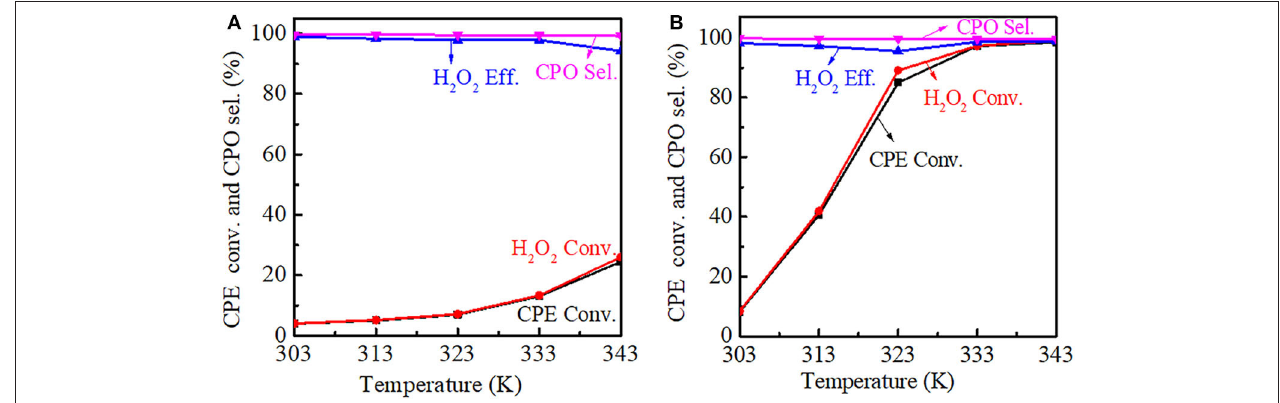
FIGURE 10 | Dependence of CPE conversion, H 2 O 2 conversion, H 2 O 2 efficiency, and CPO selectivity at different reaction temperatures over Ti-MWW (A) and R-Ti-MWW-PI (B) . Reaction conditions: catalyst, 50mg; CPE, 10 mmol; H 2 O 2 (30 wt.%), 10 mmol; MeCN, 10mL; time,